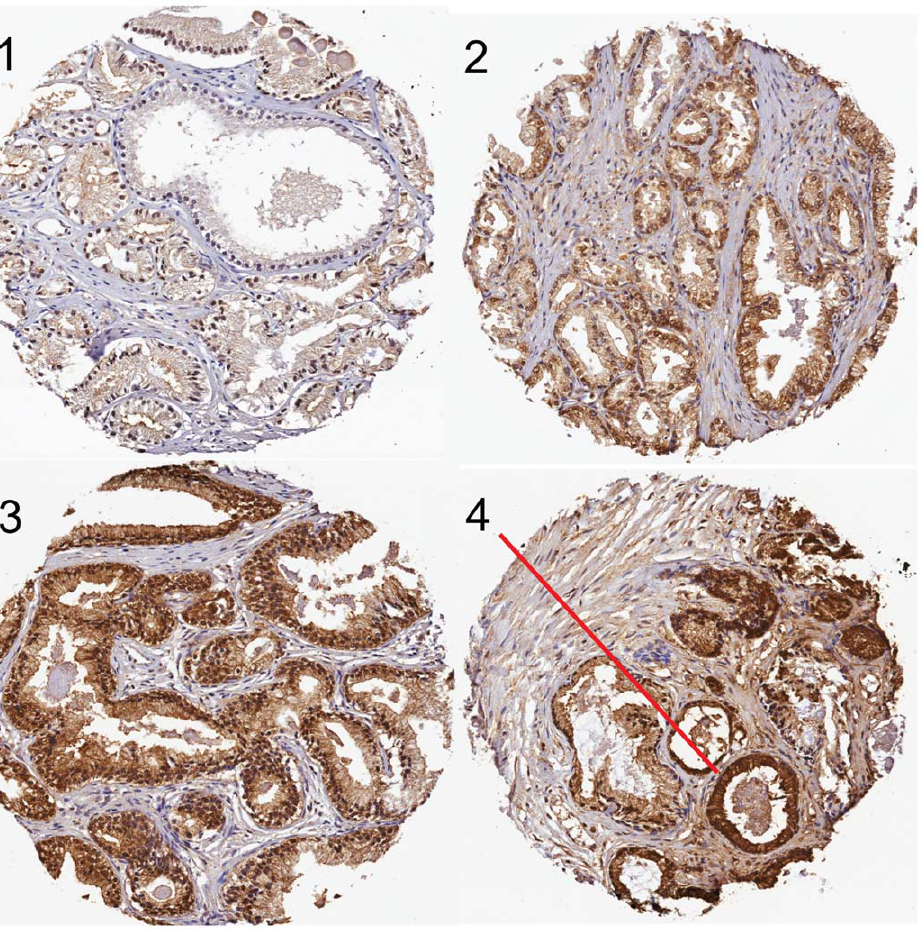
Figure 1. Examples of staining intensities for pAkt-IR ranging from 1, 2, 3 and an area (indicated) with staining 4. These photographs (20 6 ) were used as standards by both evaluators throughout the scoring phase of the project. The top two cores are from tumours, whilst the bottom two cores are from non-malignant tissue.